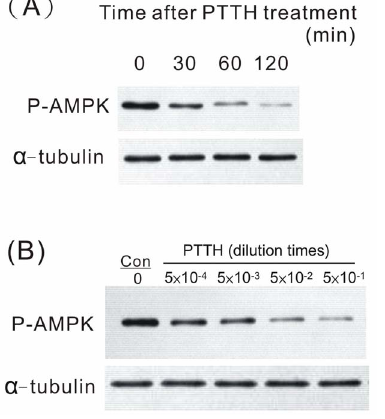
Figure 4. Time- and dose-dependent inhibitory effects of AMPK phosphorylation by PTTH. Prothoracic glands were either treated with PTTH for the indicated time points (A), treated with indicated concentrations of PTTH, or incubated with control medium (con) for 60 min (B). Results shown are representative of three independent experiments.